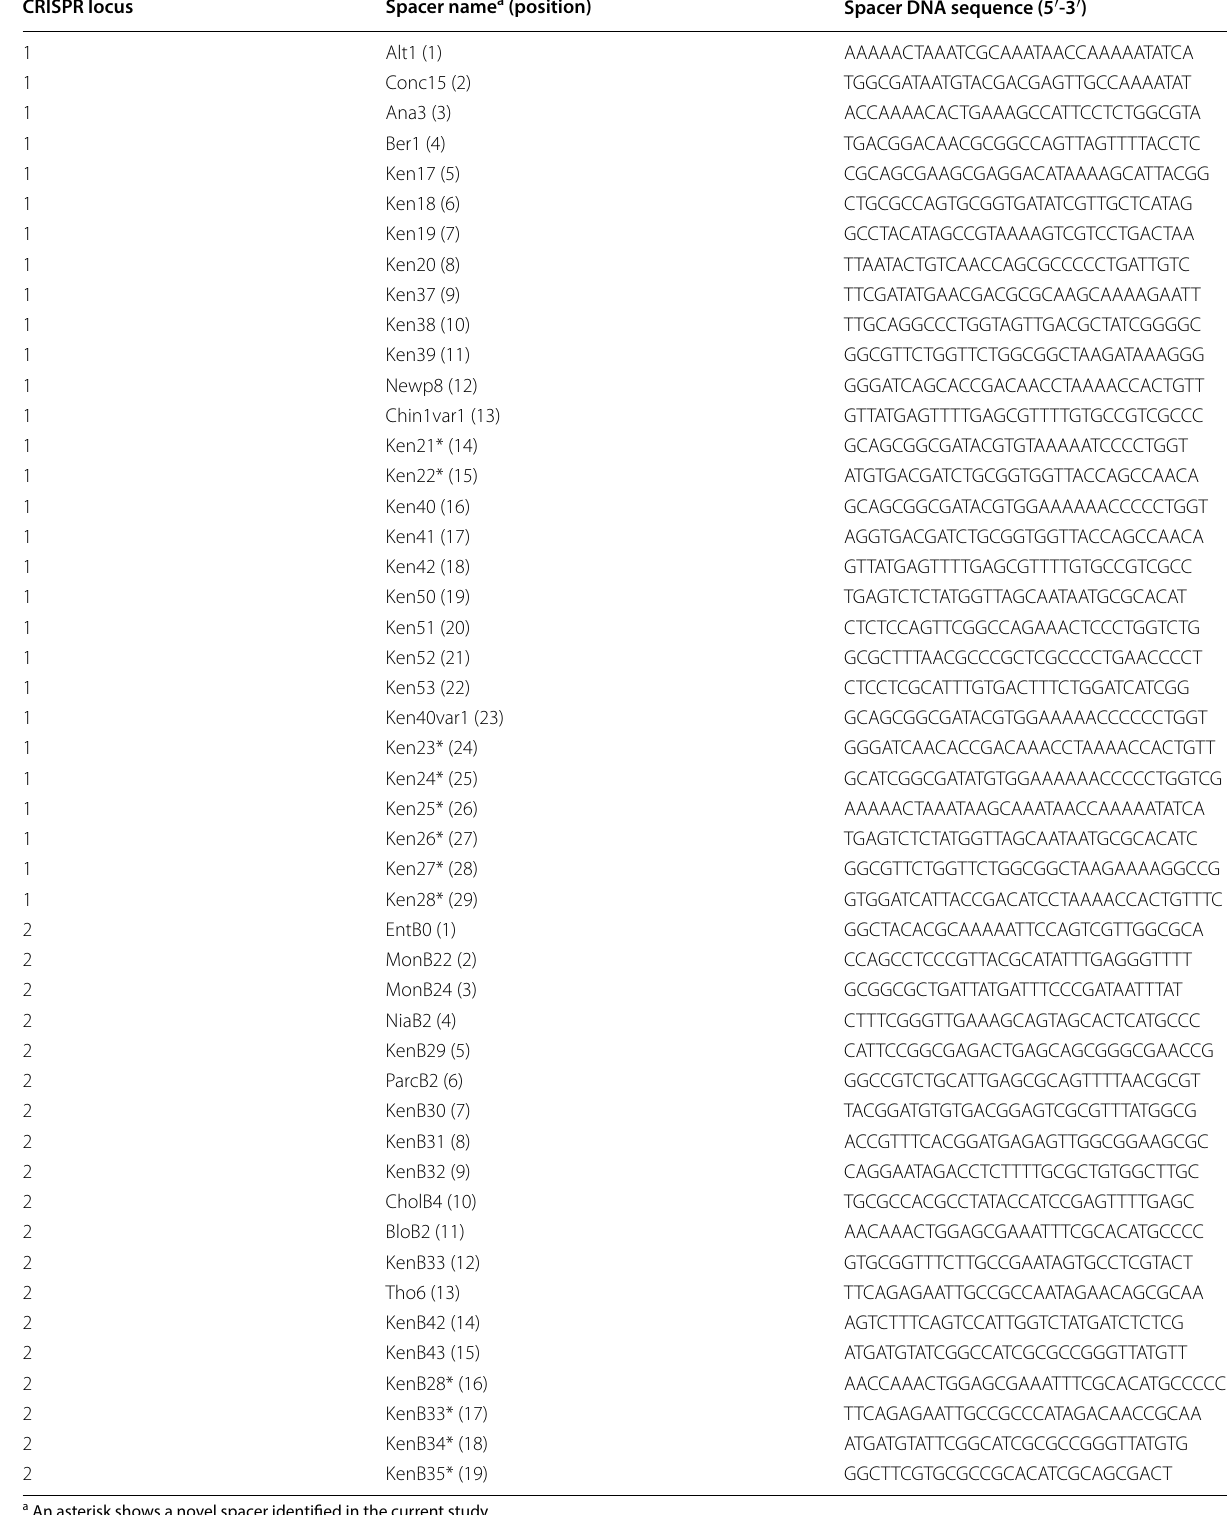
Table 4 Salmonella Kentucky spacer